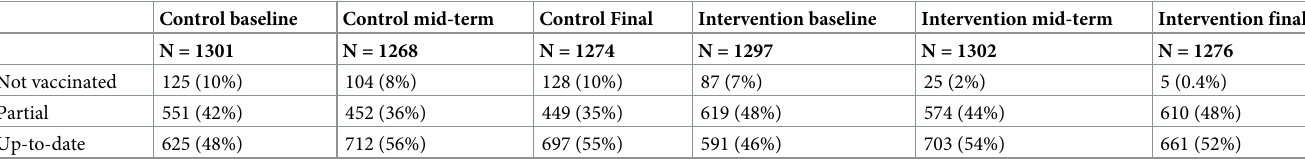
Table 3. Vaccination status of children in the cross-sectional surveys.